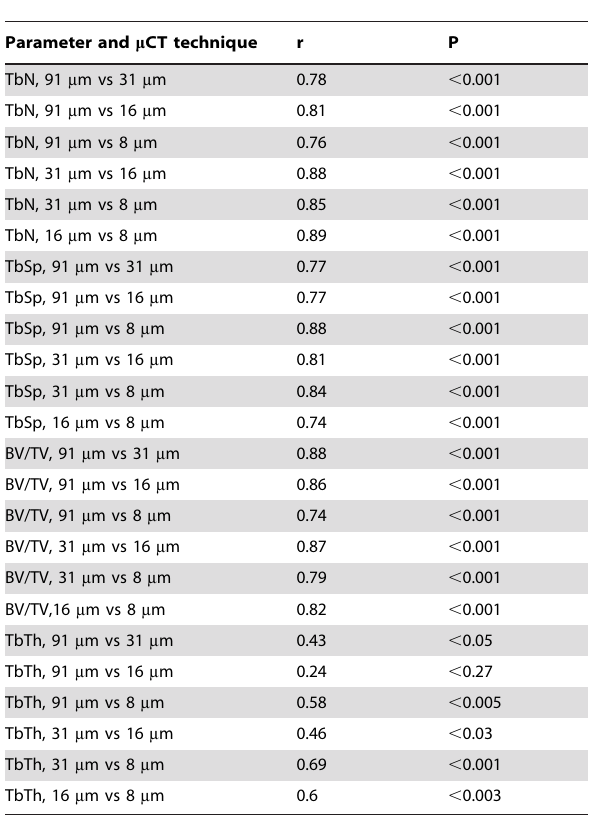
Table 4. Correlations between metaphyseal morphometric parameters (TbN, TbSp, BV/TV, and TbTh) determined by in vivo m CT vs ex vivo specimen m CT at optimal